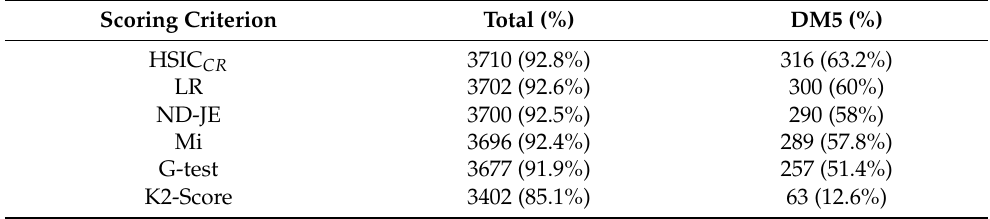
Table 3. The number of times, out of 4000 data sets generated by eight models, where k = 3, that each scoring criterion identified epistasis SNPs of snp100 for 1600 samples. The second column gives the total accuracy over a sample size of 1600. The last column gives the accuracy over a sample size of 1600 in the most difficult model. The scoring criteria are listed in descending order of total accuracy.